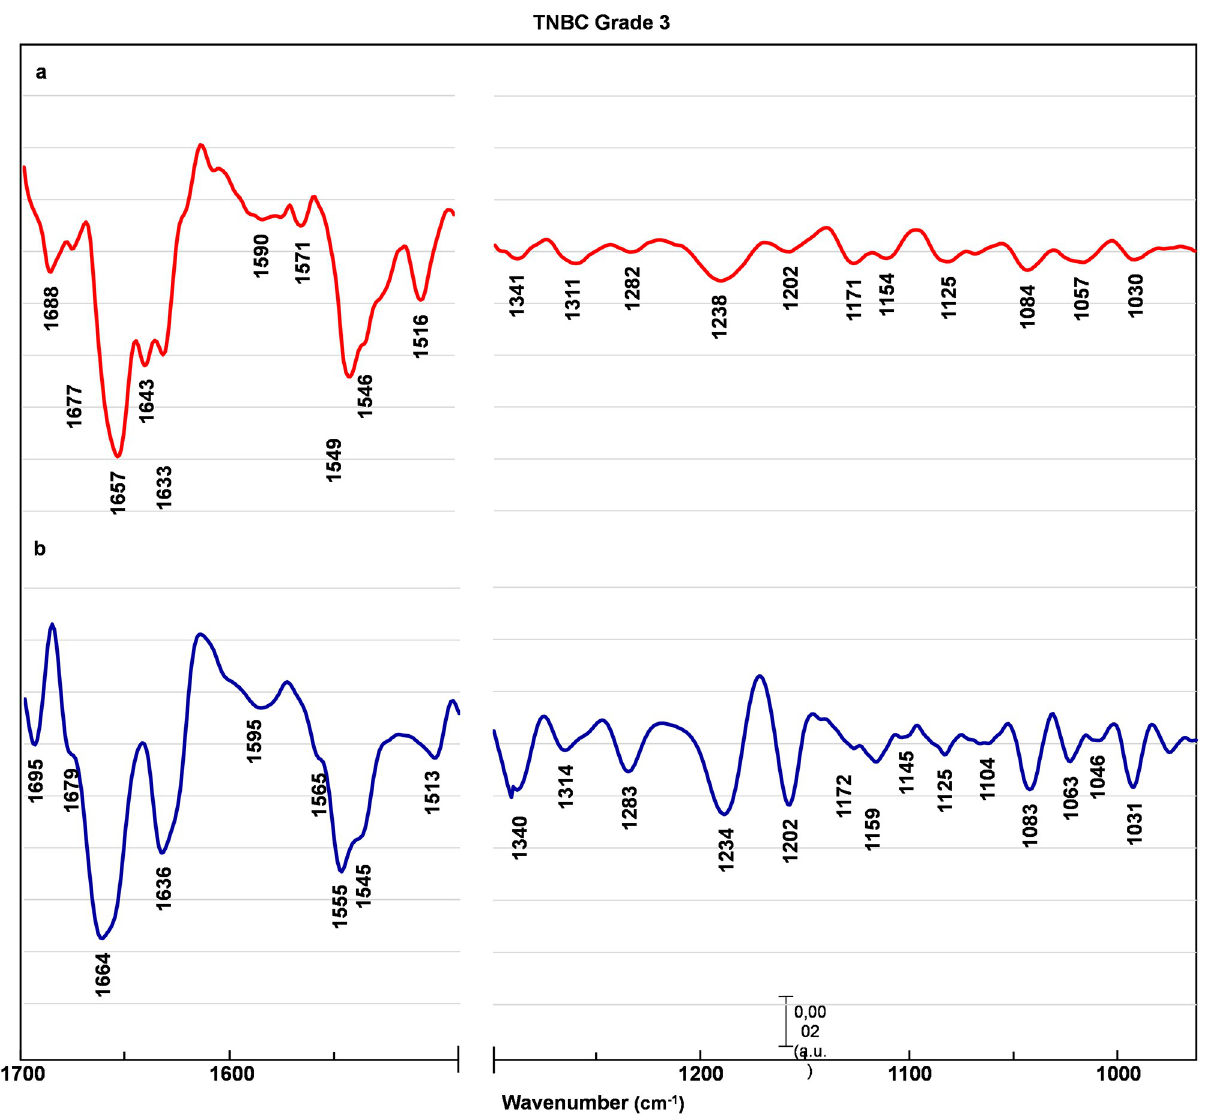
Fig 5. TNBC grade 3 averaged spectra. EMSC-corrected 2nd derivative spectra of TNBC grade 3 breast tissue before (a) and after (b) preoperative chemotherapy with assigned minima.